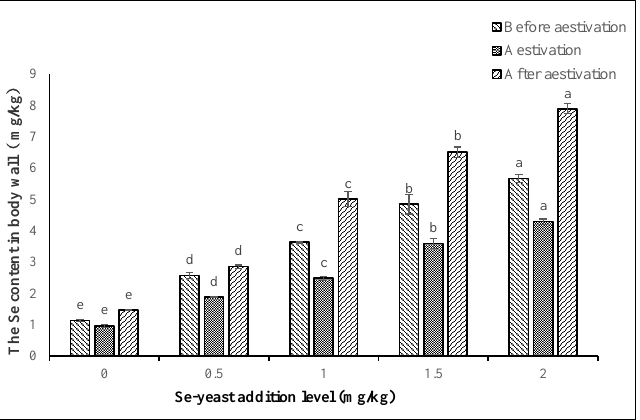
Figure 1. Effects of selenium yeast supplementation in the body wall of juvenile sea cucumber ( Apostichopus japonicus ). At each experimental stage , mean value bars bearing with different letters are significantly different between dietary groups ( p < 0.05).